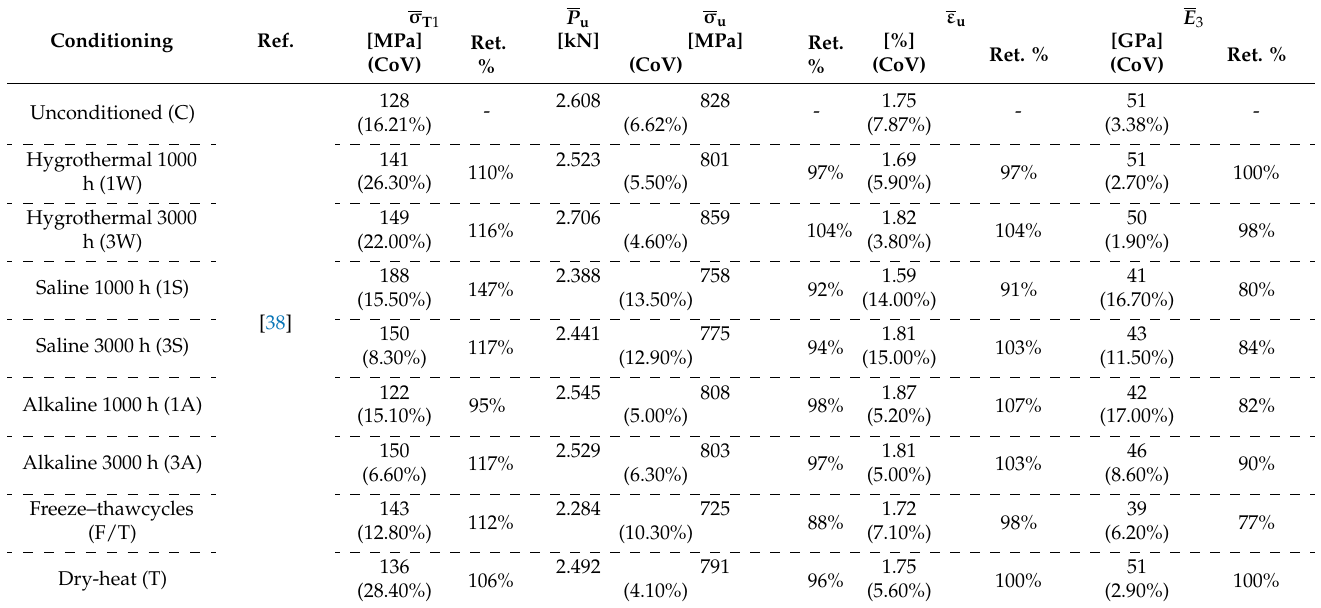
Table 5. Glass FRCM: average results of conditioned specimen groups and retained